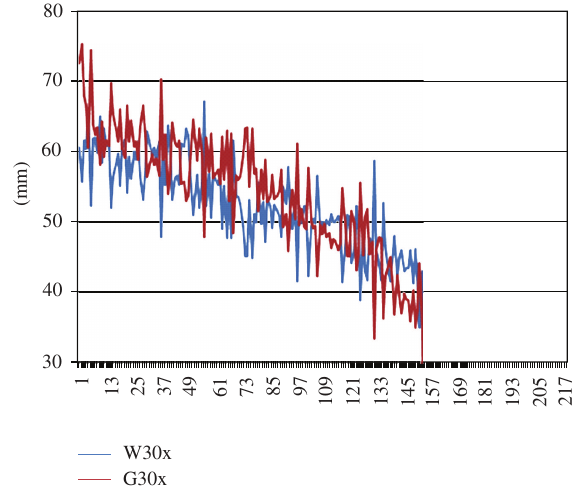
FIGURE 7: Stalk length of G30x and W30x seedlings by dish pair in the winter/spring experiments (WS1 through WS6). For explanations see Figure